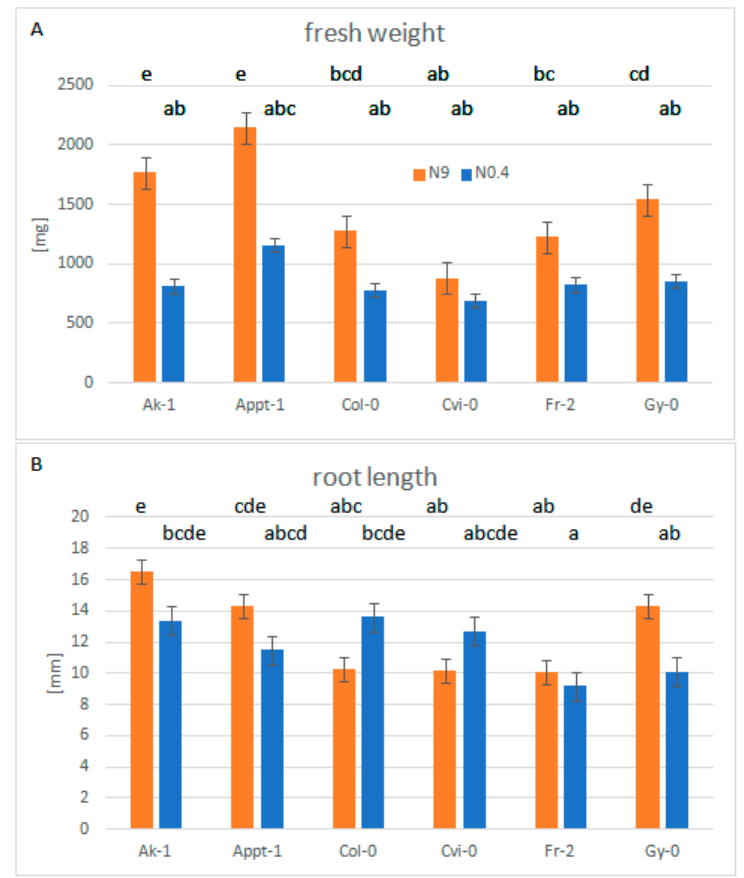
Figure 6. Rosette fresh weight and root length of 44-day old plants as parameters for plant performance under nitrogen deficient conditions. ( A ) Rosette fresh weight (mg) of selected accessions grown under + N (orange) and − N (blue) conditions in a vermiculite-based substrate. ( B ) Root length (mm) of selected accessions grown under +N (orange) and − N (blue) conditions in vermiculite-based substrate. Bars show adjusted means and standard errors estimated over three experiments using a 2-factor ANOVA ( n = 6). Different letters indicate significant differences ( p < 0.05 after Tukey correction).